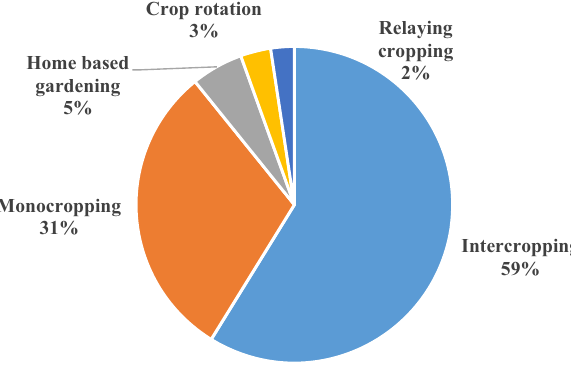
Figure 4: Farming systems practiced in Lablab production in Tanzania ( χ 2 = 15.049; p = 0.314 )